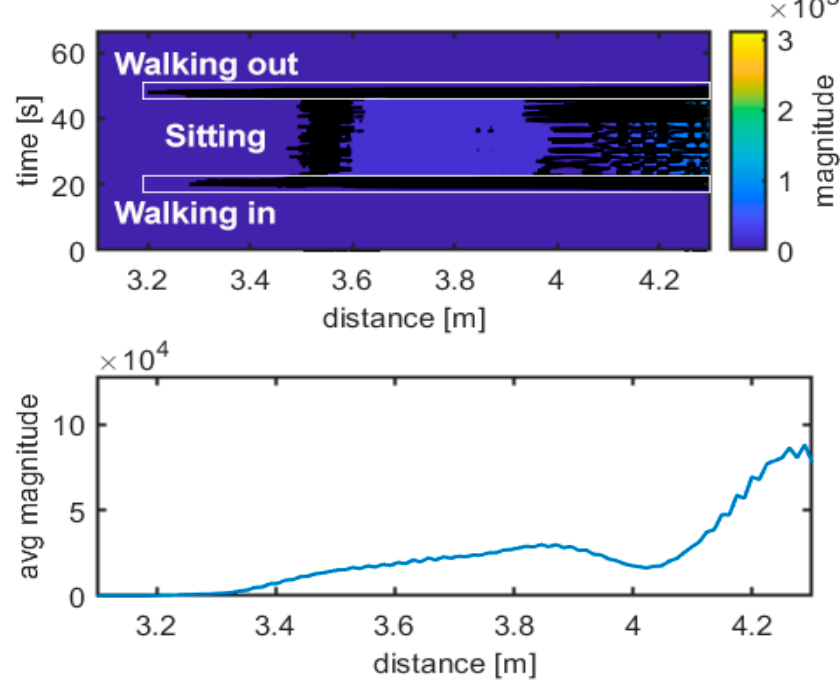
Figure 8. Movement identification. Experimental results: walking in–sitting frontside–walking out. Magnitude unit is µV.